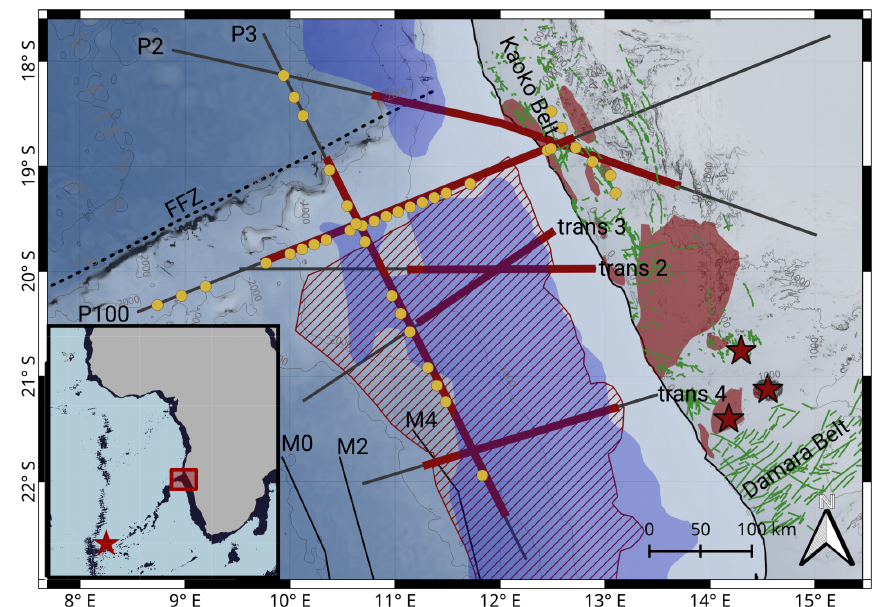
Figure 1. Topographic map of the survey area with geophysical stations and profiles, as well as geological and tectonic features. Yellow circles are marine MT stations, and grey lines are seismic profiles, where red marks areas of interpreted high-velocity magmatic underplating. Studies are performed by Fromm et al. (2017a, 2015) (profiles P100 and P2), Planert et al. (2017) (profile P3), and Gladczenko et al. (1998) (profiles trans 2–4). Red dashed area is the outline of seismically imaged seaward-dipping reflectors (SDRs) (Koopmann et al., 2016), and black dashed line is the Florianopolis Fracture Zone (FFZ). Blue area marks the outline of sediment cover thicker than 3km, taken from Maystrenko et al. (2013). Red areas onshore are the Etendeka continental flood basalts; red stars mark the Brandberg, Messum, and Doros intrusive complexes (Owen-Smith et al., 2017; Teklay et al., 2020). Green lines represent magmatic dykes of the Kaoko and Damara belts (Salomon et al., 2017; Trumbull et al., 2004; respectively). Magnetic lineations M0 to M4 are taken from Moulin et al. (2010). In the map inlay, the read box marks the large map’s extent and the red star is the location of the Tristan hotspot. Dark areas are bathymetric features, where water depth is less than 3000m; the entire hot spot track of Walvis Ridge clearly links the Namibian landfall to the mid-ocean